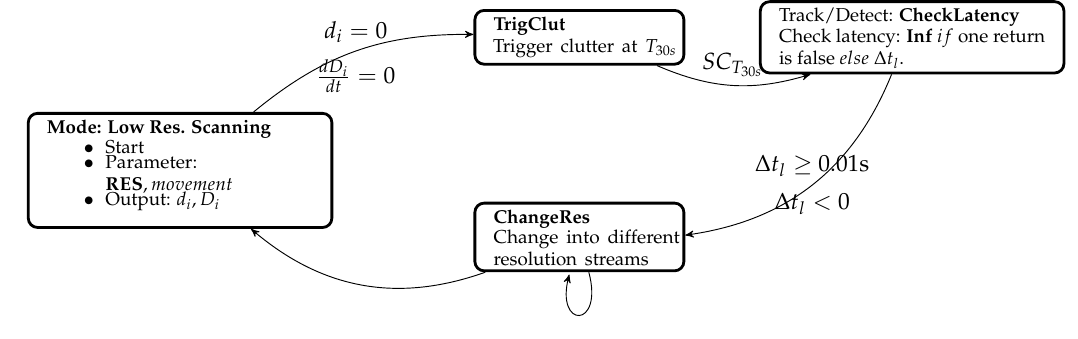
Figure 8. Stateflow for primary and secondary sensors